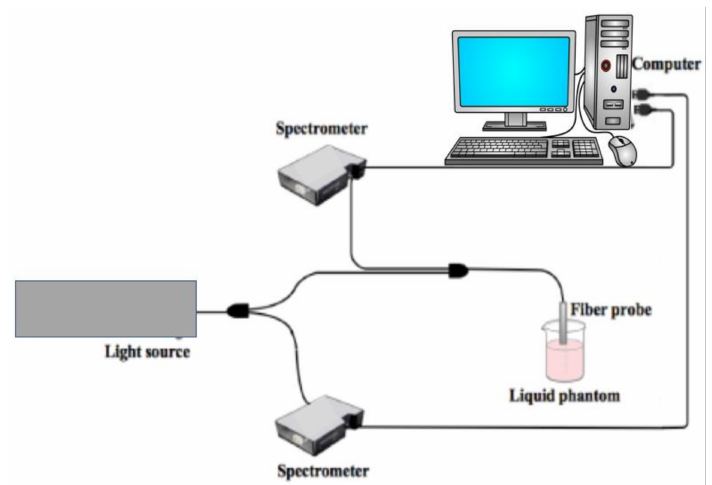
Figure 2. Schematic layout of an experimental set-up for diffuse reflectance measurements. A broadband light source is used, and a spectrometer allows wavelength selection of the incident beam. The second spectrometer is employed for monitoring the reflected